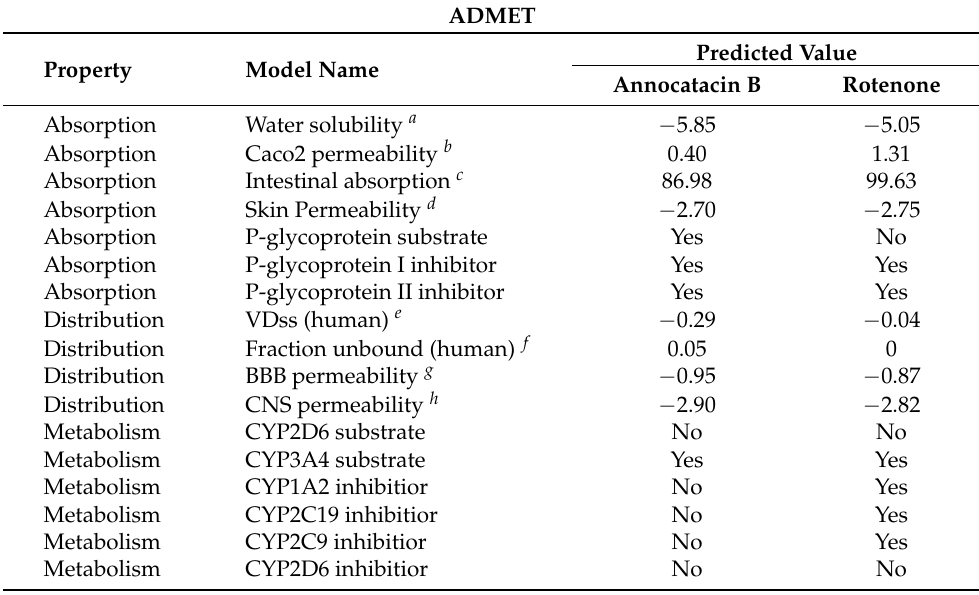
Figure 2. Chemical structure of Annocatacin B and Rotenone molecules. Calculated molecular ESP surfaces of ( a ) annocatacin B, and ( b ) rotenone. In the left panel, ESP surfaces obtained at the DFT level using the CAM-B3LYP/TZVP method. In the right panel, ESP surfaces are obtained with APBS methodology and the Hirshfeld’s atomic charges. On all surfaces, the different colors indicate their molecular electrostatic properties; red for the most nucleophilic zones; dark blue for the most electrophilic zones, and green for the neutral zones. Table 2. ADMET prediction of annocatacin B and rotenone by pkCSM